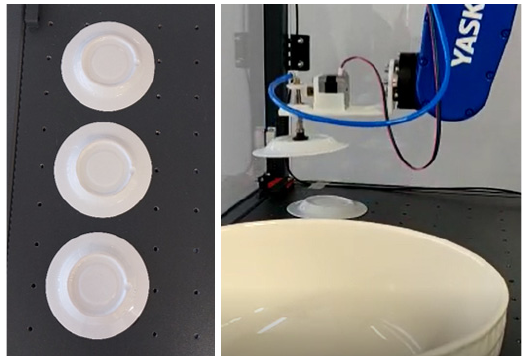
Figure 4. Arrangement and grasp of the saucers. Source: (own).